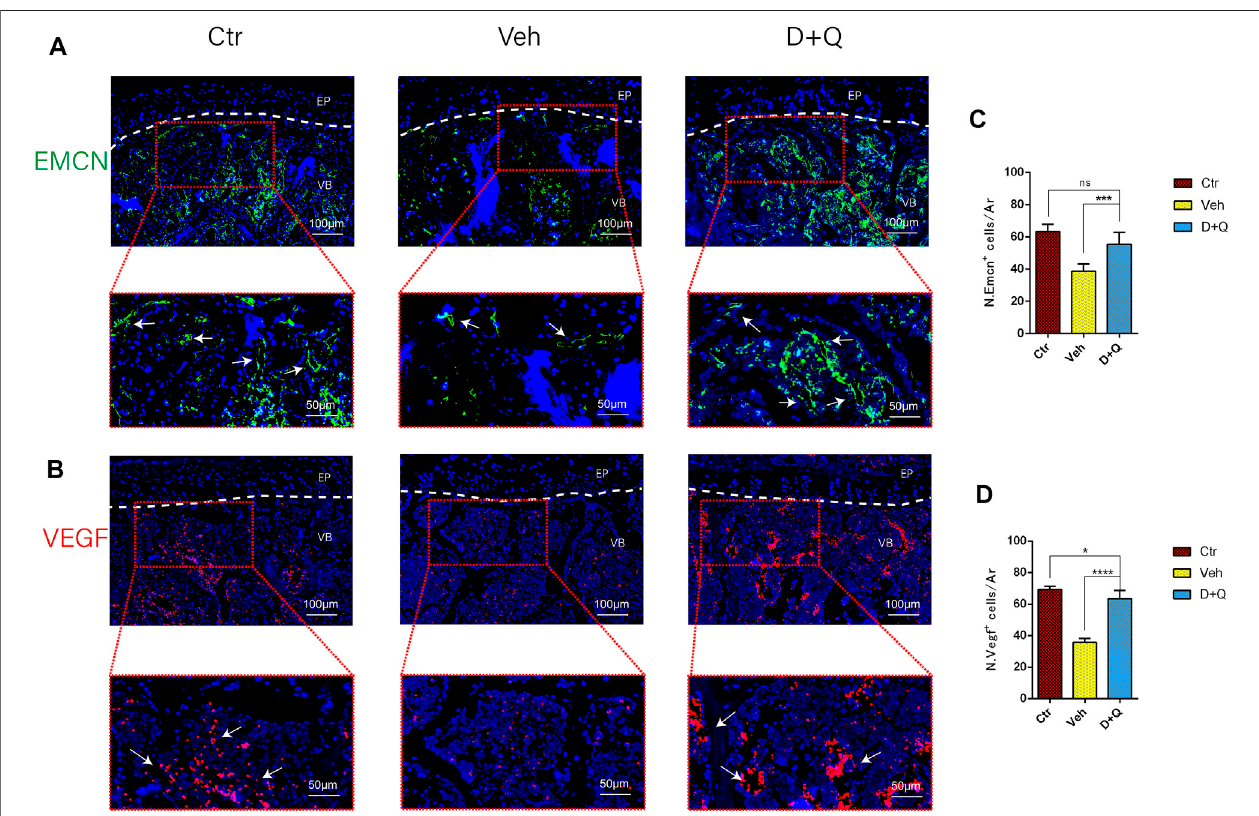
FIGURE 6 | Qualitative and quantitative detection of endothelial and angiogenic marker in the sub-endplate region. Immuno fl uorescence staining of vascular endothelial cell marker (A) EMCN and (B) VEGF could be observed in the coronal sections of intervertebral disc (IVD). Cell nuclei were stained with DAPI (blue). (C,D) Quantitative data ofthe EMCN and VEGF cells in the marrow space ofbony endplate. Data are represented asmean ± SD. NP, nucleus pulposus; AF, annulus fi brosus; EP,endplate;Ctr,controlgroup;Veh,vehiclegroup;D+Q,dasatinibandquercetingroup.Scalebar=100 μ m(upper),50 μ m(lower);D+Qvs.CtrgroupandVeh group; ns, no signi fi cance; * p < 0.05; ** p < 0.01; *** p < 0.001; **** p < 0.0001.